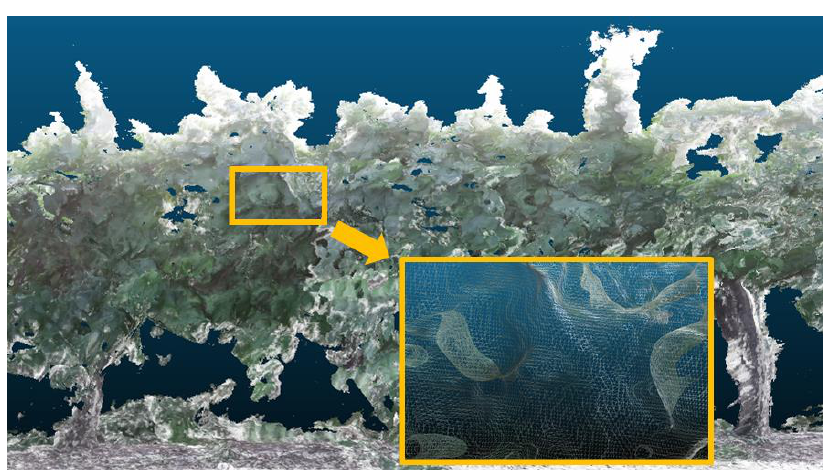
Figure 13. Details of a 3D reconstruction of a vine that shows the triangular mesh obtained from a point cloud.